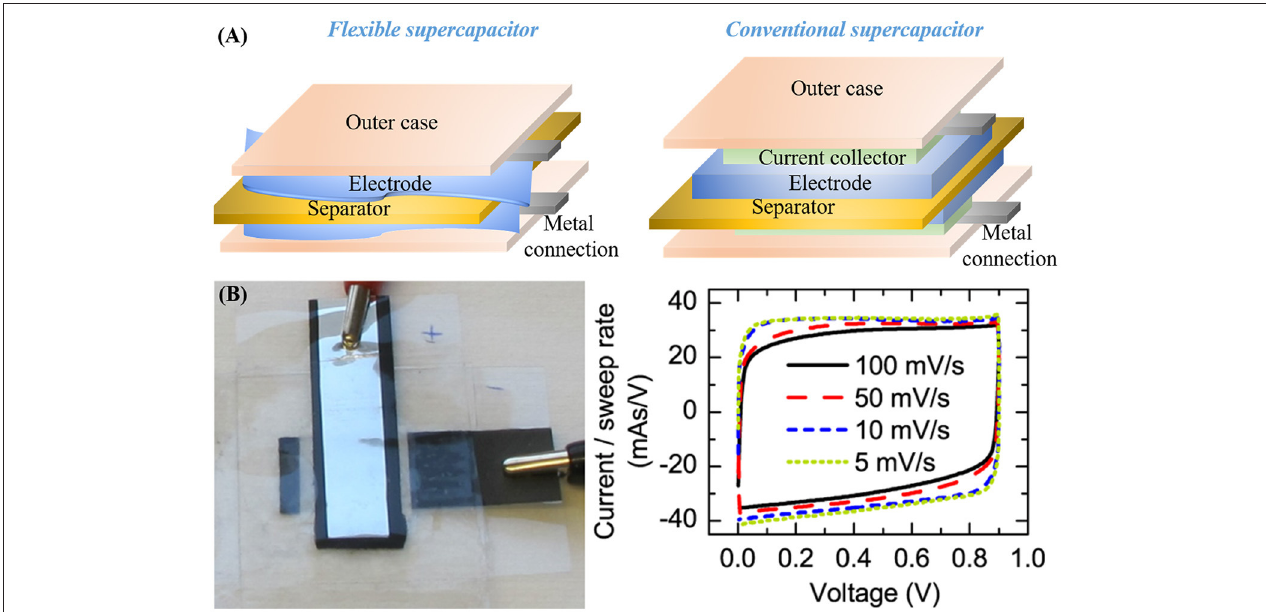
FIGURE 1 | (A) Schematic overview of a flexible supercapacitor as compared to conventional supercapacitor and (B) Photo of flexible supercapacitor composed of poly(3,4-ethylenedioxythiophene) and graphene oxide composite films on flexible graphite-poly(ethylene terephthalate) substrate and its current-voltage